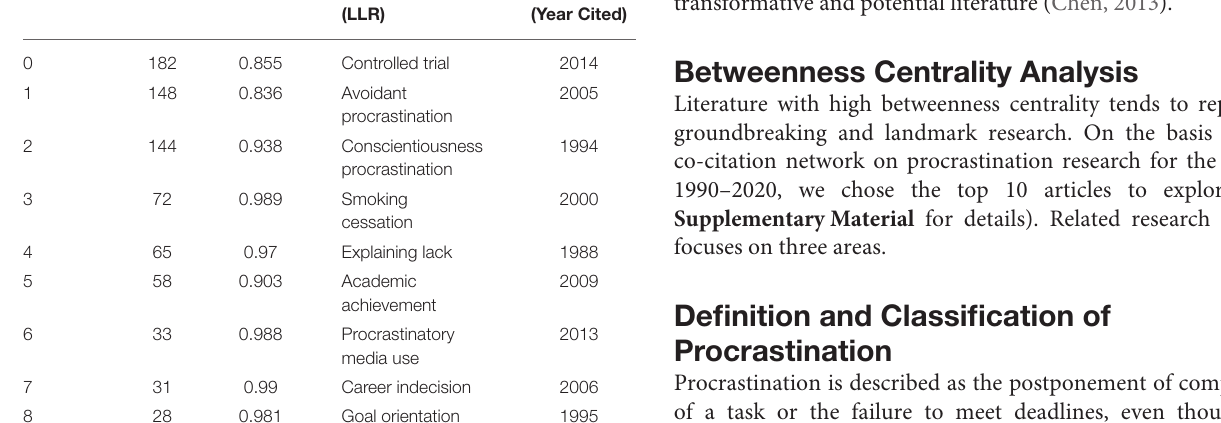
TABLE 1 | Summary of the nine largest clusters in procrastination research. Cluster